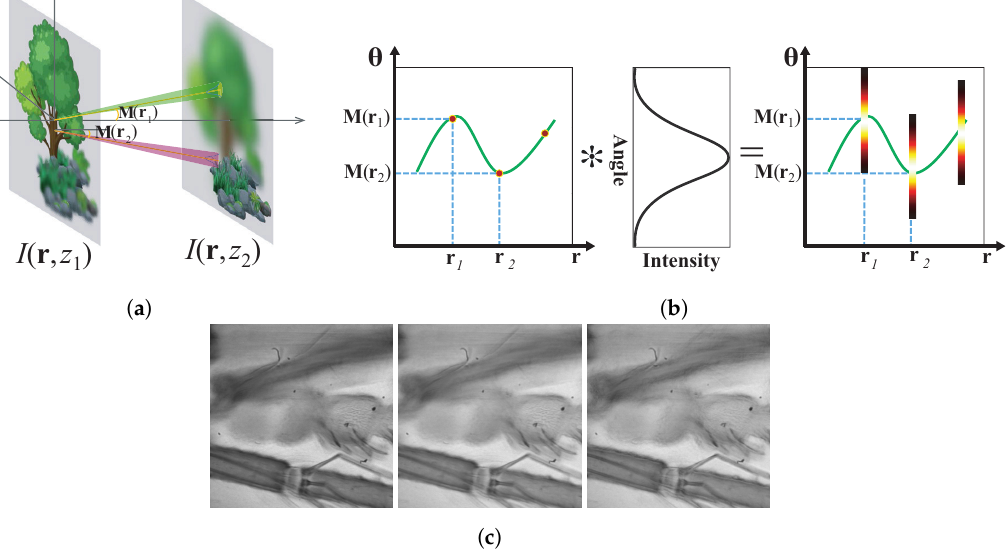
Figure 11. Principle of Light field moment imaging (LFMI) represented in the spatial domain ( a ) and WDF ( b ), and one example of different view images reconstructed by it ( c ), adapted with permission from [64], Optical Society of America).